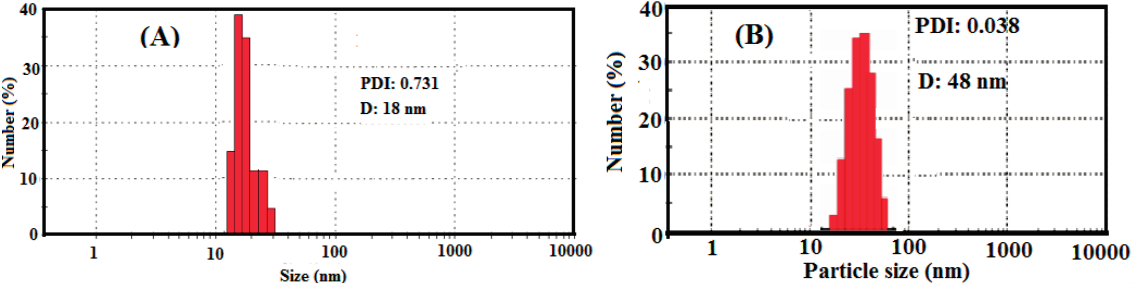
Figure 8. DLSA data of magnetite coated with ( A ) R-AN and ( B ) RK-AN amidoximes in (ethanol/water; 60/40 volume %) 1 mM KCl at pH = 7.